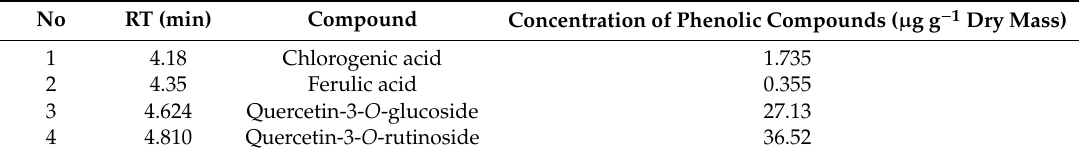
Table 1. Phenolic compound concentrations in the horsetail extract.